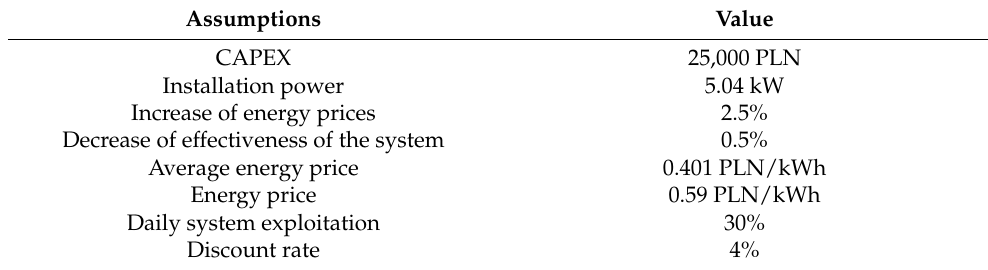
Table 1. Financial analysis